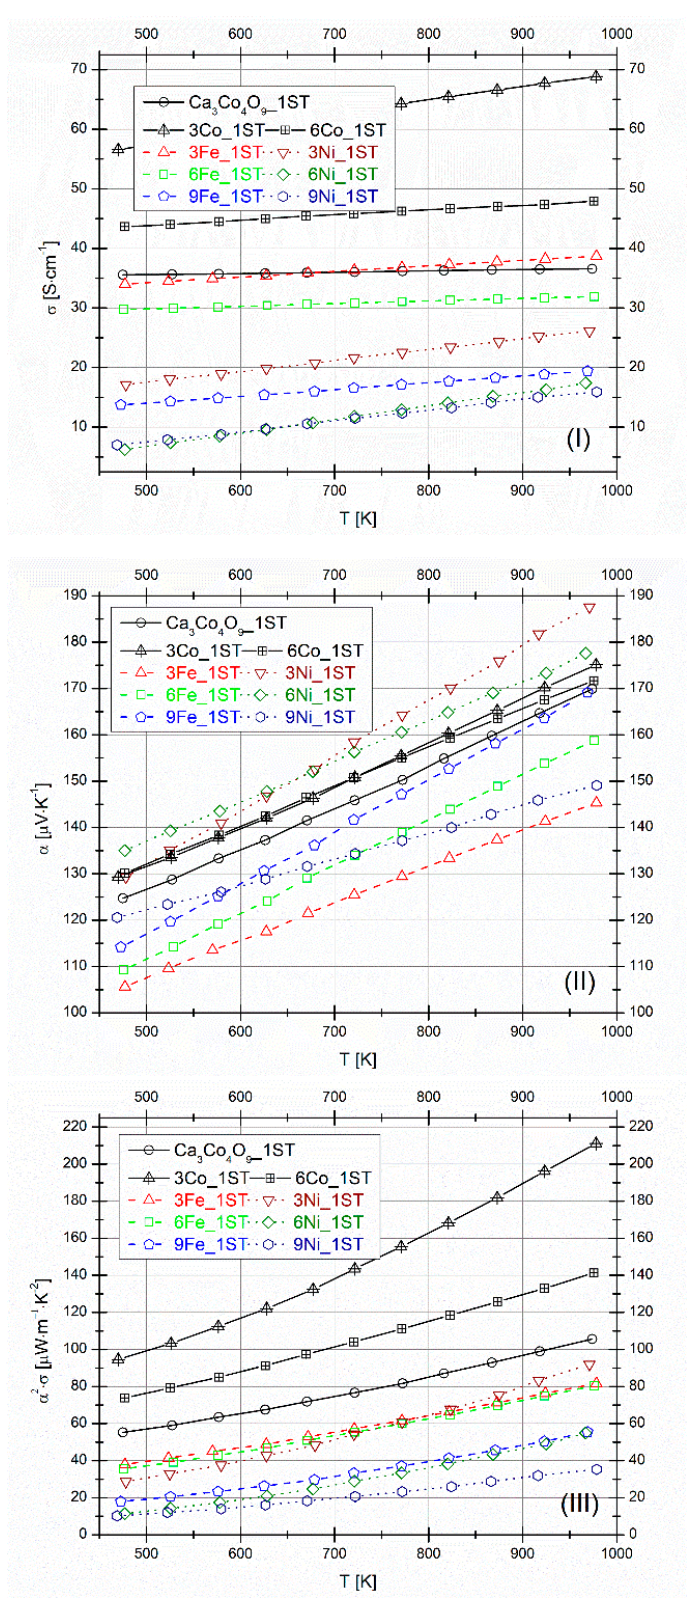
Figure 4. Electrical conductivity ( I ), Seebeck coefficient ( II ), and power factor ( III ) for 1ST sintered samples. The results for selected Co additions are presented for comparison.